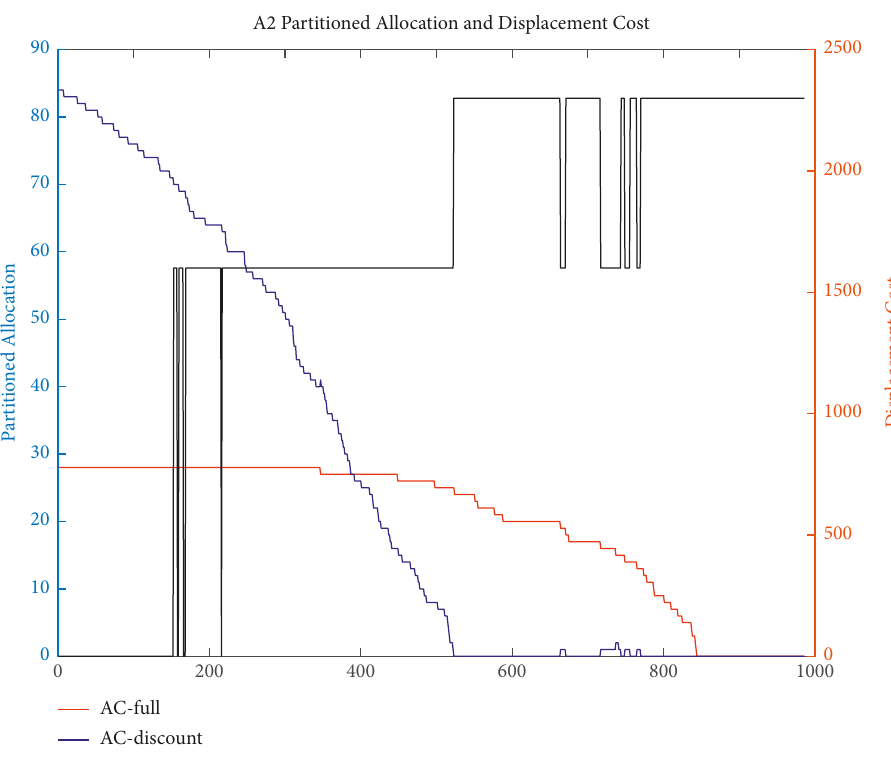
Figure 8: Partitioned allocation and displacement cost of flight A2.